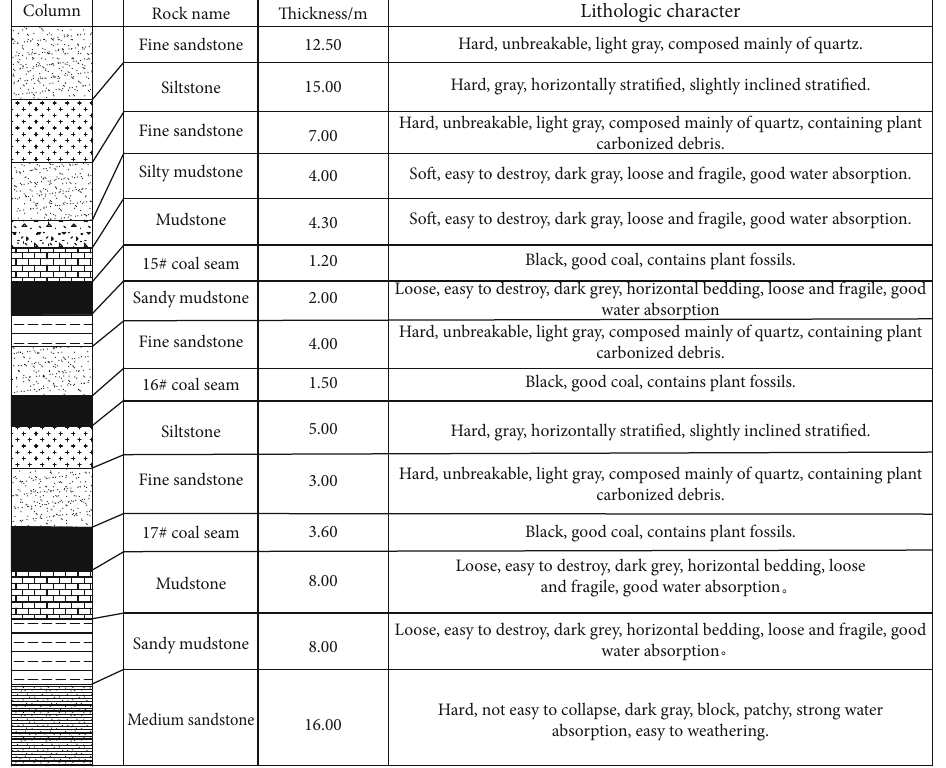
Figure 1: Comprehensive histogram of coal seam occurrence.